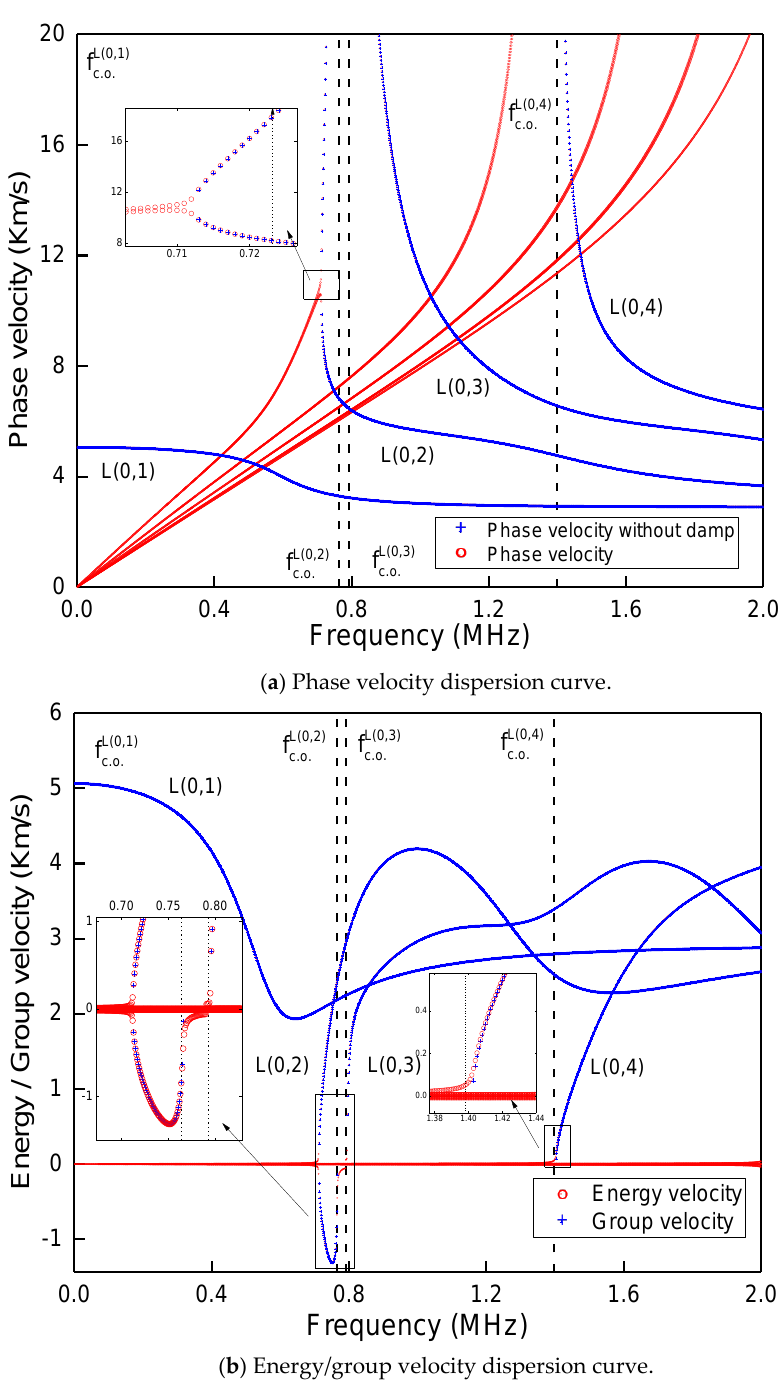
Figure 11. Low-order longitudinal wave mode: ( a ) Phase velocity dispersion curve; ( b ) Energy/group velocity dispersion curve.